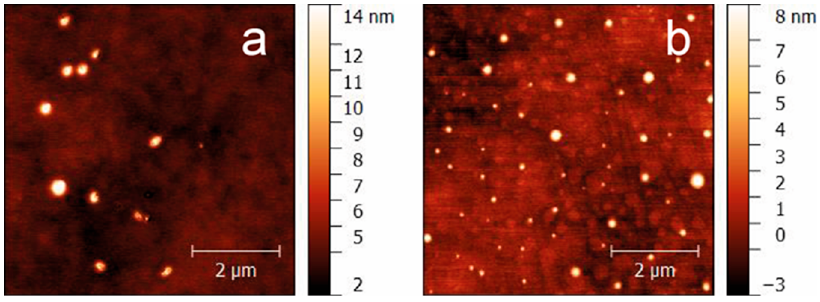
Figure 2. AFM images of Nio ( a ) and NioIbu ( b ) samples. Table 2. Vesicle characterization. Nio, pH-Tw20Gly niosomes; NioIbu, pH-Tw20Gly niosomes loaded with a 5% Ibuprofen Hepes solution.